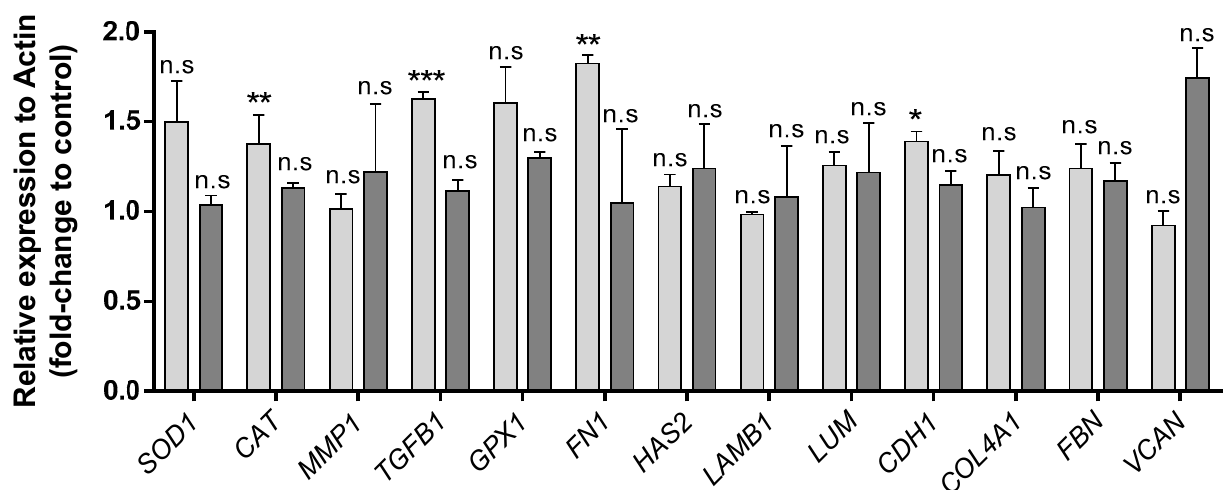
Figure 3. Effect of multi-layer GO on the expression of 13 genes (SOD1, CAT, MMP1, TGFB1, GPX1, FN1, HAS2, LAMB1, LUM, CDH1, COL4A1, FBN, and VCAN) at non-cytotoxic concentrations (0.01 and 0.05 µg/mL) in the human keratinocyte HaCaT cell line after 24 h. Data are presented as mean ± SEM from three replicate measurements. Results are represented as fold-change of control and relative expression to ACTB. (* p < 0.05; ** p < 0.01; *** p < 0.001, n.s: not significant).